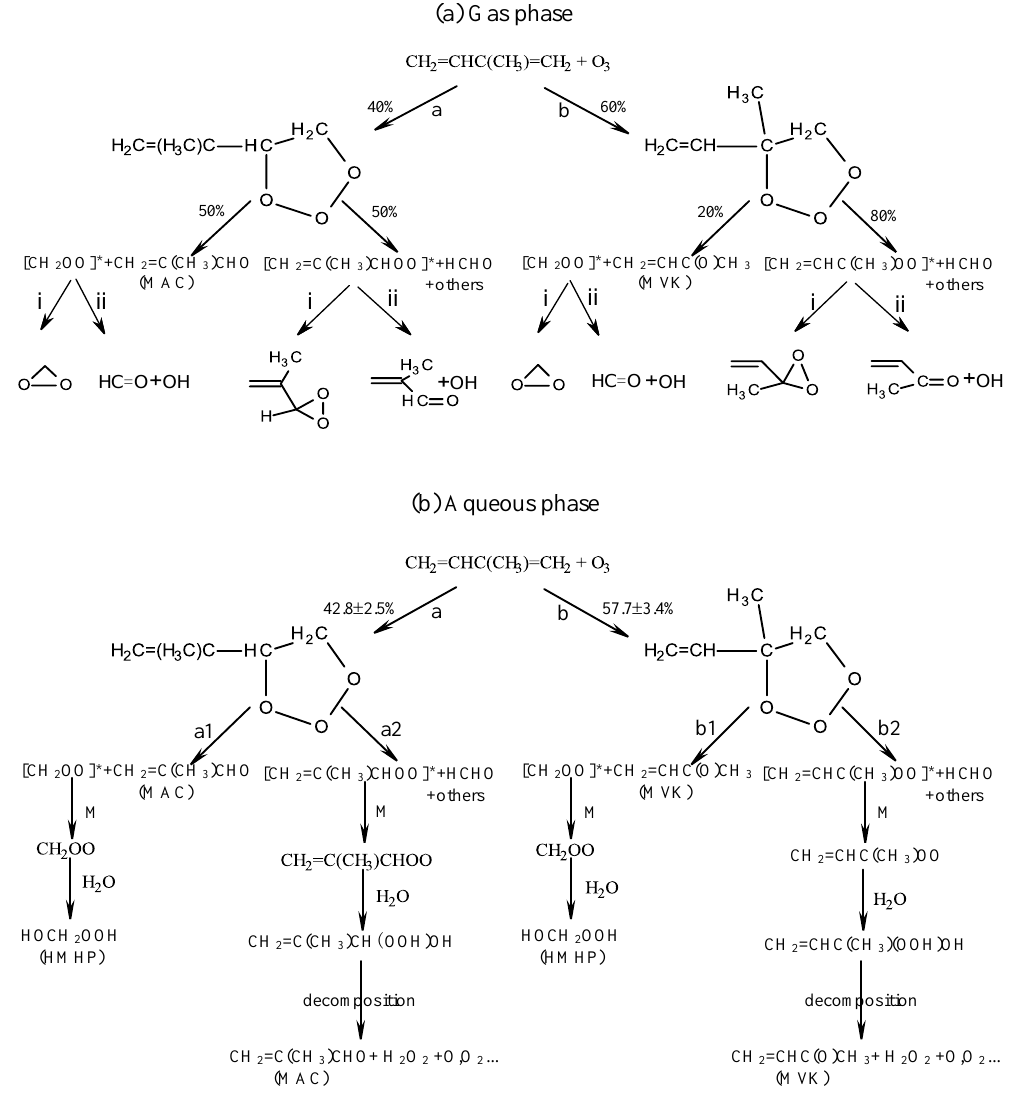
Fig. 3. Mechanisms of ozonolysis of isoprene in (a) the gas phase and (b) aqueous phase. In (a) , pathway i: isomerization; pathway ii: decomposition, stabilization and bimolecular